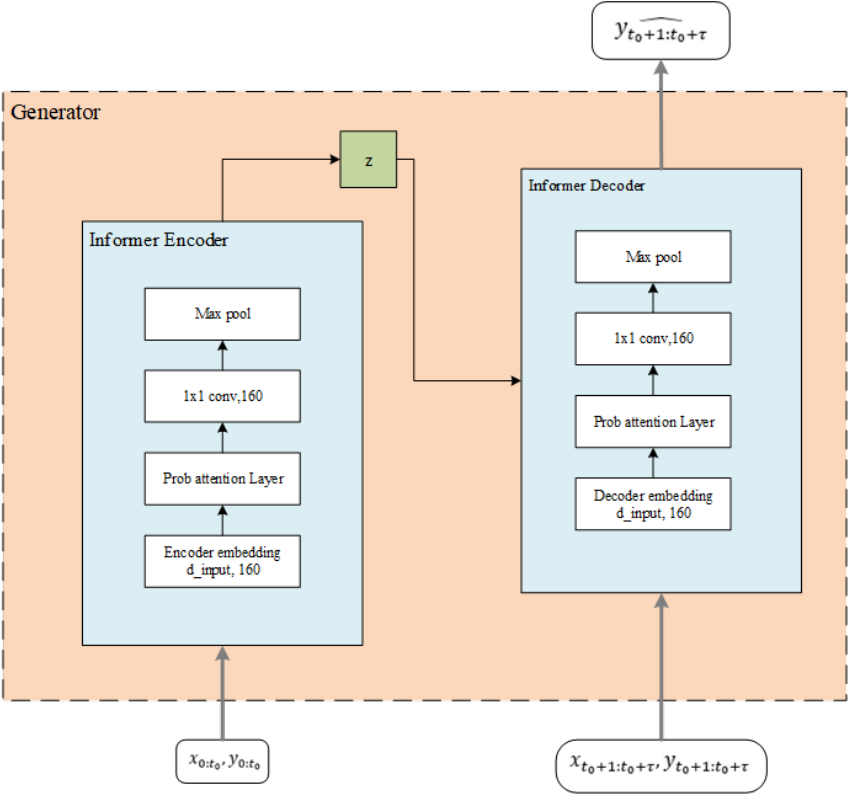
Figure 2. Generator